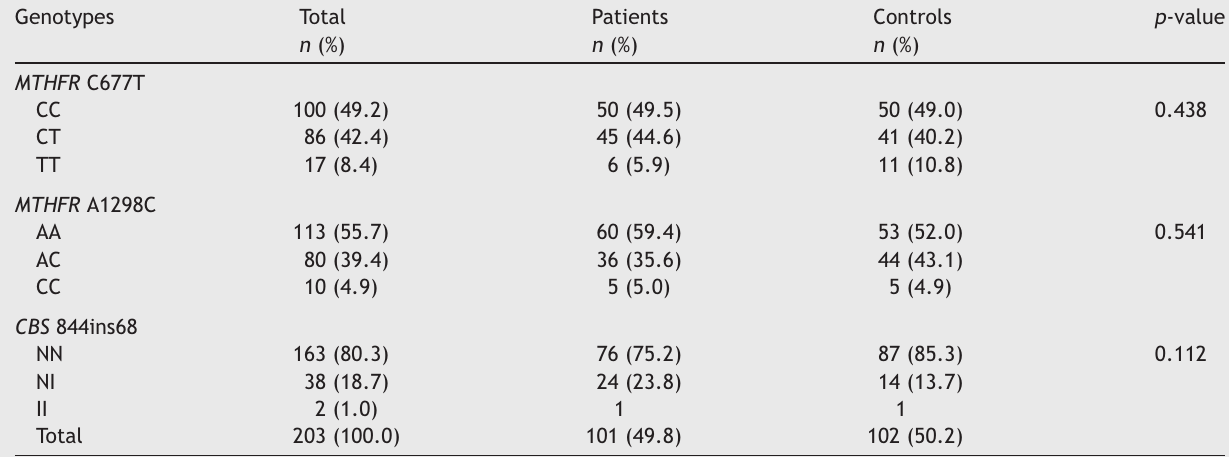
Distribution of MTHFR and CBS genotypes among oral cancer patients and control groups. Genotypes Patients